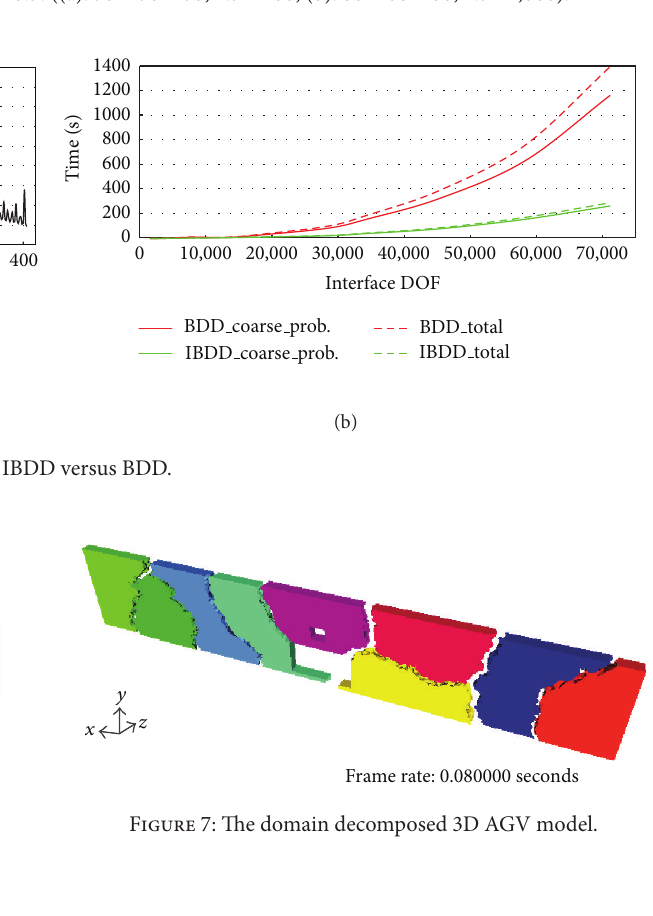
fill-in occurs in the position of some zero elements due to the presence of any previous nonzero element in the same row.